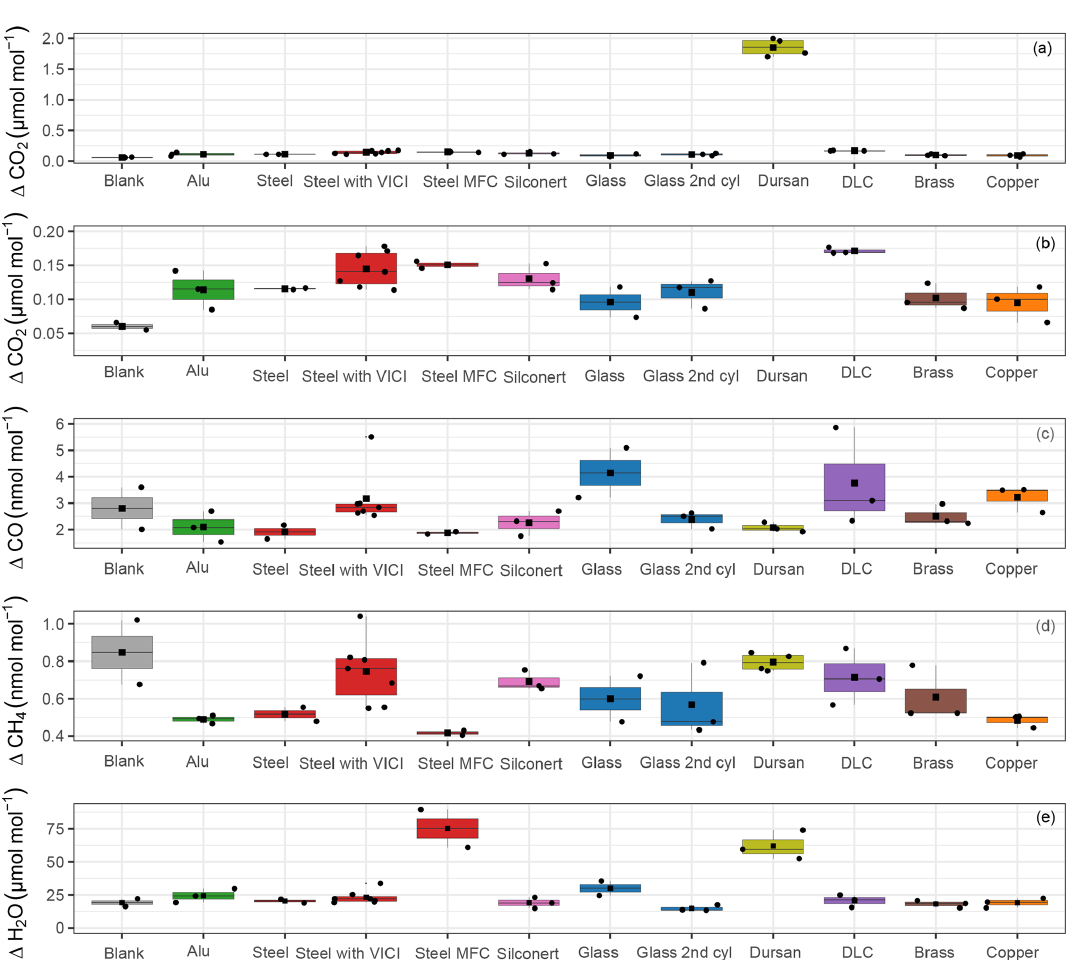
Figure 4. Box plots for all materials for the species (a) CO 2 , (b) zoomed-in image for CO 2 , (c) CO, (d) CH 4 and (e) H 2 O. The y axes show the maximal amount fraction difference relative to the initial amount fraction. Horizontal lines in each box plot shows the median, whereas the square in the center of the box is the mean of the maximal amount fractions of the